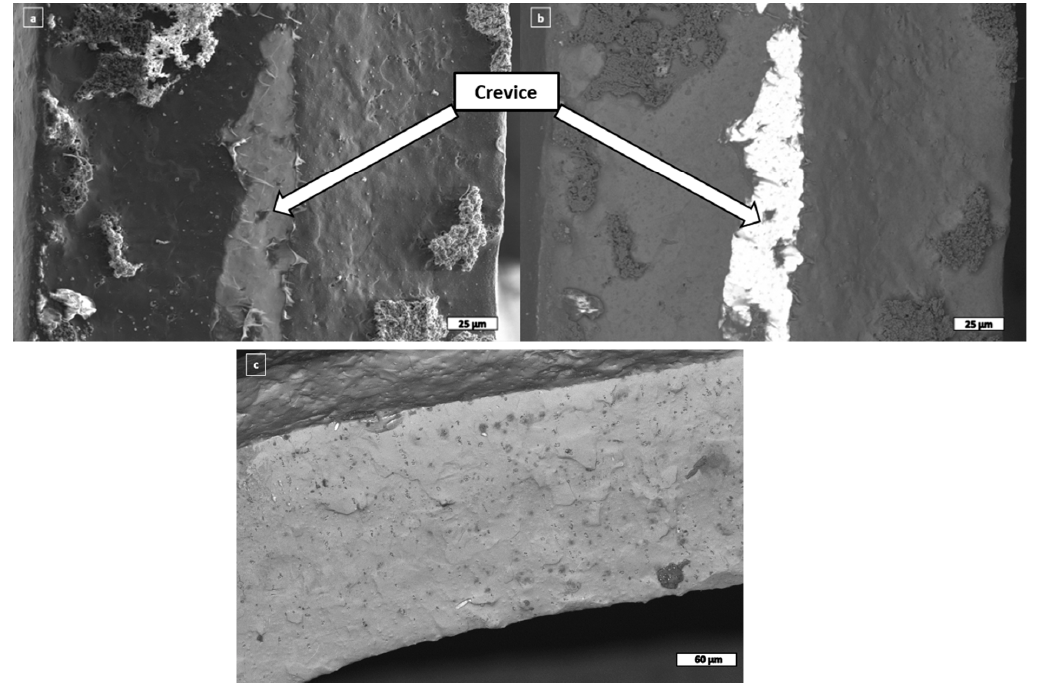
Figure 12. Surface morphology viewed by SEM; ( a ) Secondary electron image identified crevices in the Parylene C coating on an expanded Zn stent (crevice is lighter gray); ( b ) Back-scattered electron image (crevice is white); ( c ) Back-scattered electron image of a strut from an unexpanded stent showing a uniform coating of Parylene C, free of crevices.